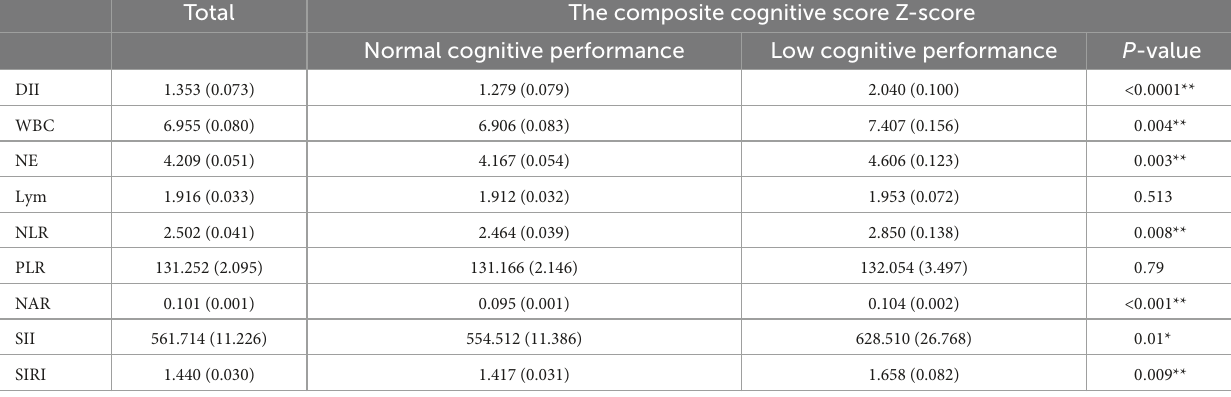
TABLE 2 Comparison of dietary inflammatory index and blood inflammatory indicators between the cognitive impairment group and the normal group. Total The composite cognitive score Z-score Normal cognitive performance Low cognitive performance P